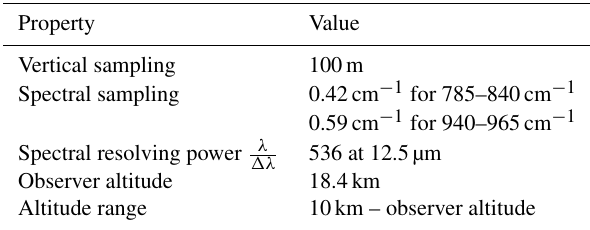
Table 1. CRISTA-NF instrument properties used in the